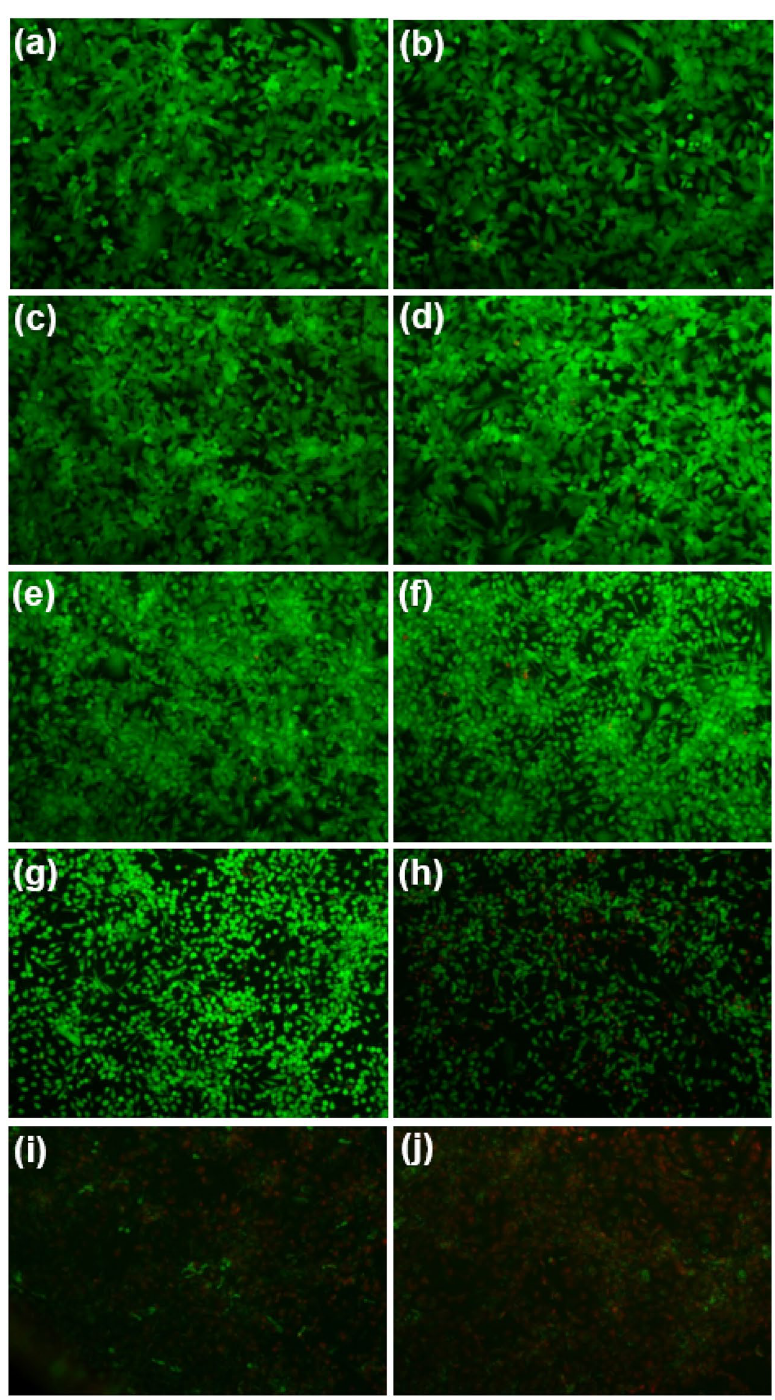
Figure 7. Fluorescence images for morphologies of GFP-tagged Human Umbilical Vein Endothelial cells (HUVECs) on TCP and treated cells with different salt solutions at 10 × magnification under fluorescence microscopy. HUVECs have an elongated morphology on the surface of TCP: ( a ) Control; ( b ) 2.5%; ( c ) 5%; ( d ) 7.5%; ( e )10%; ( f ) 12.5%; ( g ) 15%; ( h ) 20%; ( i ) 25%; ( j )